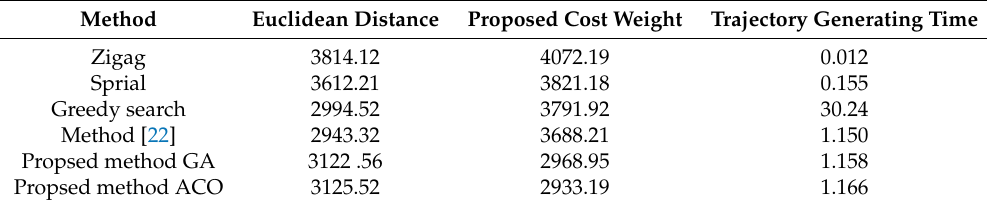
Figure 14. Generating navigation sequences and associated cost weight for the 11 × 11 workspace of CCPP methods. ( a ) zigzag scanning, ( b ) spiral scanning, ( c ) greedy search, ( d ) method [22], ( e ) Proposed method with GA, ( f ) Proposed method with ACO. Table 5. Comparison results of CCPP